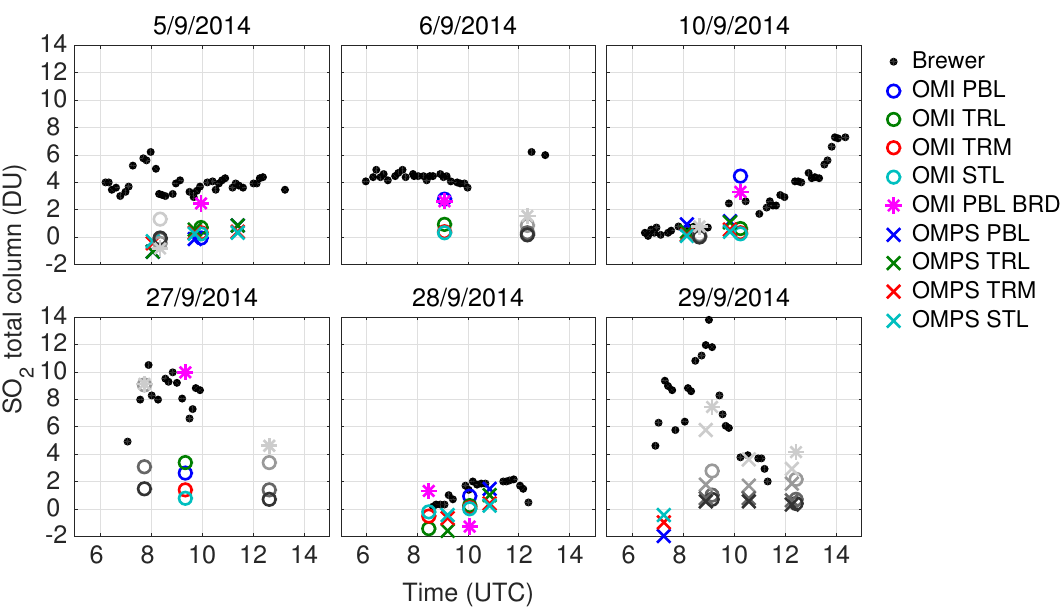
Figure 2. SO 2 vertical columns in Sodankylä, Finland during selected days of September 2014. Black dots refer to ground-based Brewer measurements, circles to OMI SP and crosses to OMPS observations. Different colours correspond to different satellite products sensitive to different altitude regions: PBL (blue), TRL (green), TRM (red) and STL (light blue). The pink stars refer to the PBL product processed using the BRD algorithm. PBL, TRL, TRM and STL satellite products for cloudy scenes (cloud fraction larger than 0.3) are shown in grey (from light to dark grey, respectively) and should be considered with